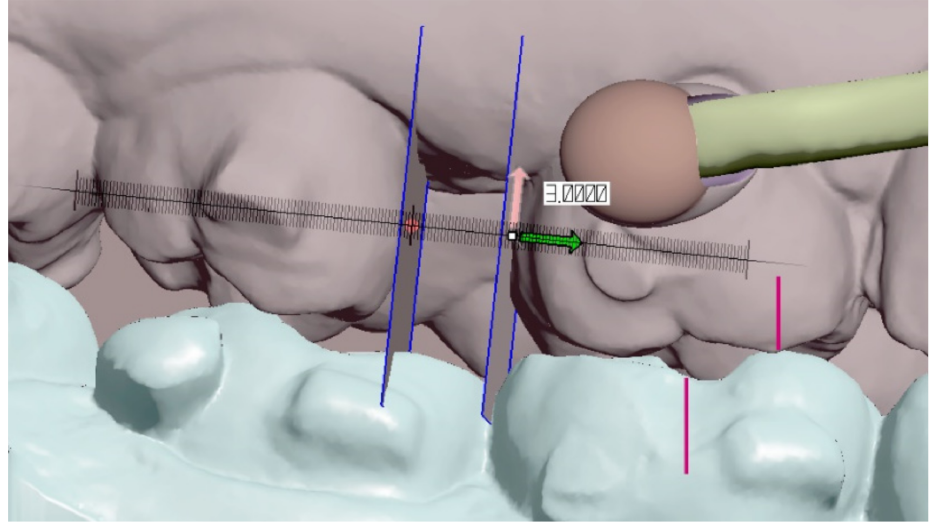
Figure 5. Digital measurement of planned clinical target (amount) of distalization in Autodesk Meshmixer—free software for working with 3D objects—in this case, the digital intra-oral